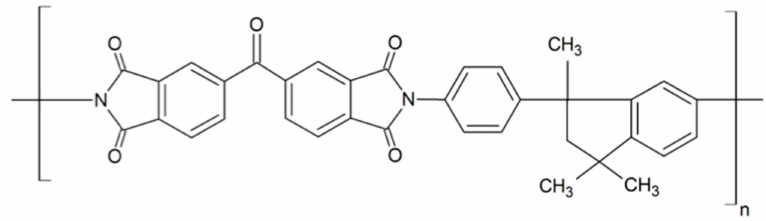
Figure 1. Chemical structure of the repeating unit of Matrimid ®